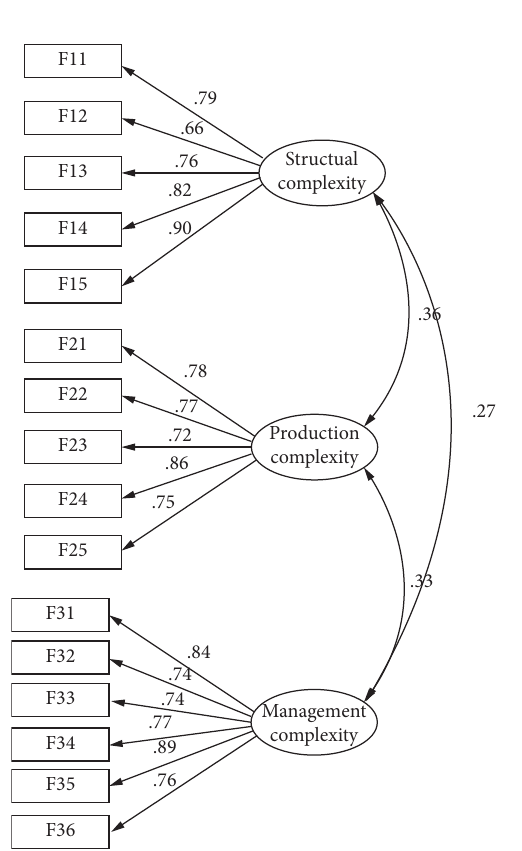
Figure 3: First-order CFA standardized model for the complexity index system. Table 9: Goodness-of-fit test for the first-order CFA model.